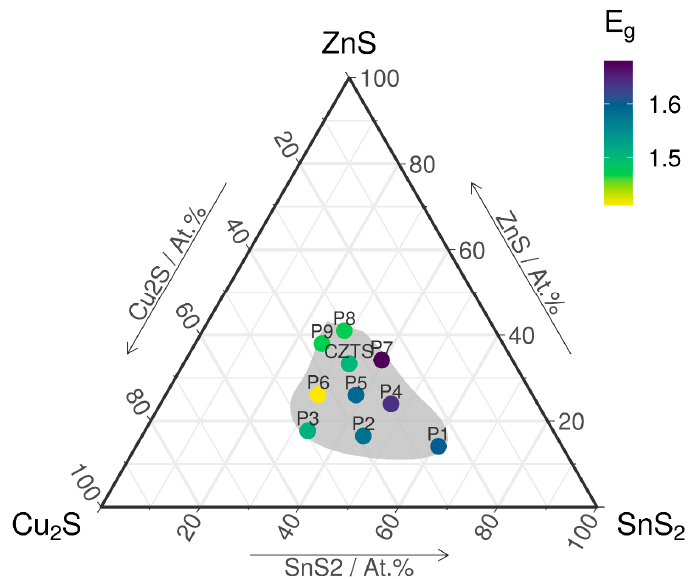
Figure 6. The distribution of the bandgap energy after sulfurization